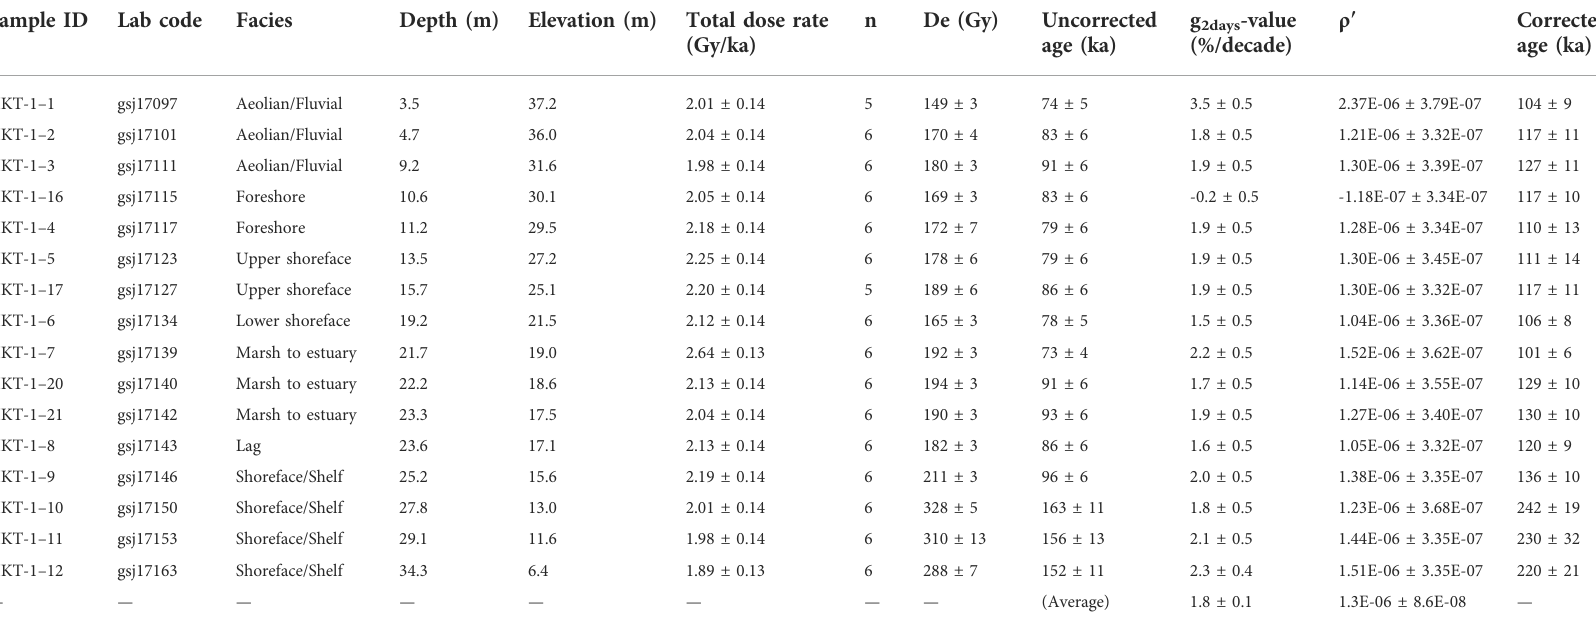
TABLE 5 pIRIR 225 age estimates. n = the number of aliquots used for age estimation, D e = equivalent dose, ρ ’ = dimensionless density of the recombination